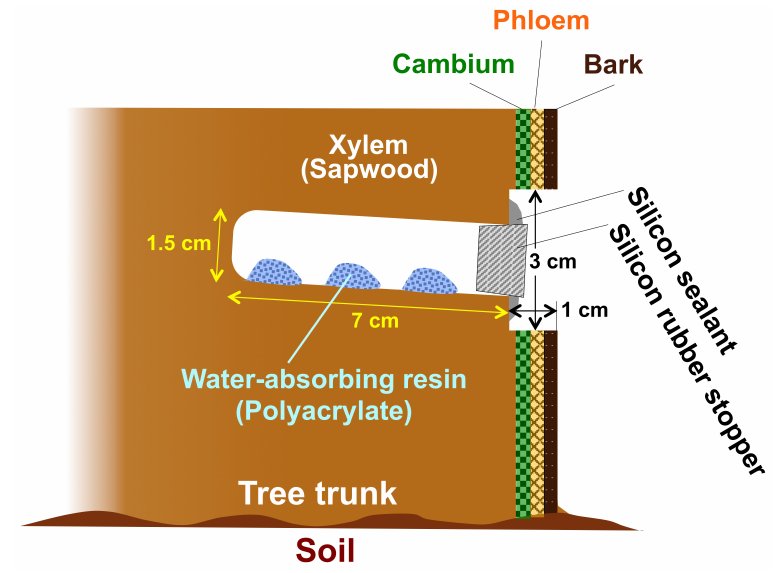
Figure 1. Method used to sample xylem sap from adult tree